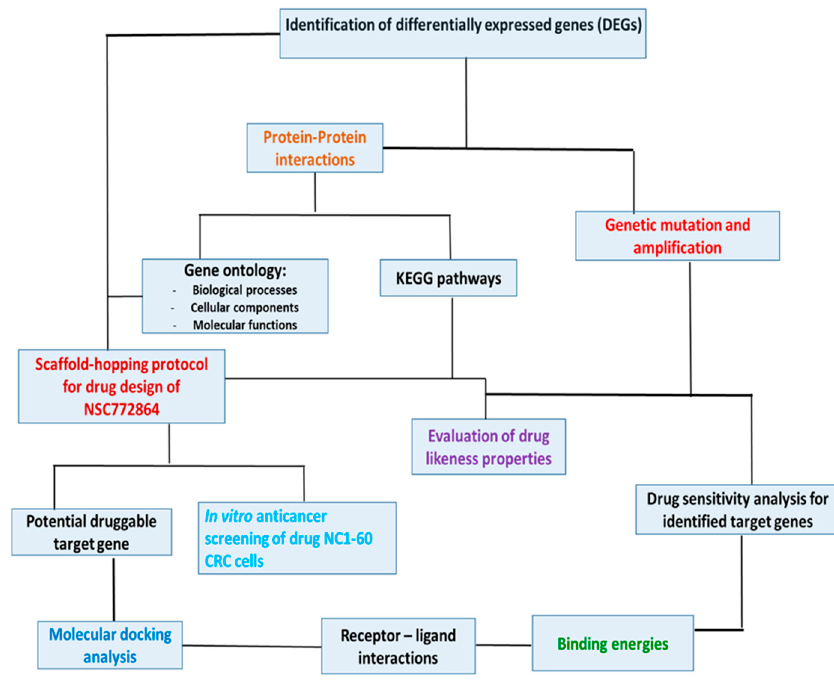
Figure 1. Schematic diagram representing the study design.